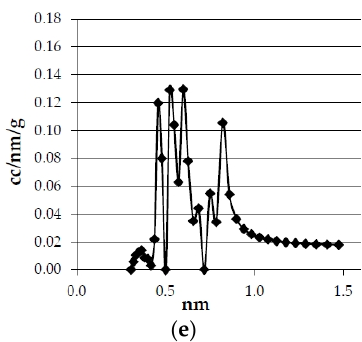
Figure 6. Pore size distribution of commercial reducers and olives and eucalyptus bioreducers (obtained at 750 °C and 3 °C ∙ min − 1 ). ( a ) Olives; ( b ) Metallurgical coke; ( c ) Eucalyptus; ( d ) Petroleum coke; ( e ) Anthracite.